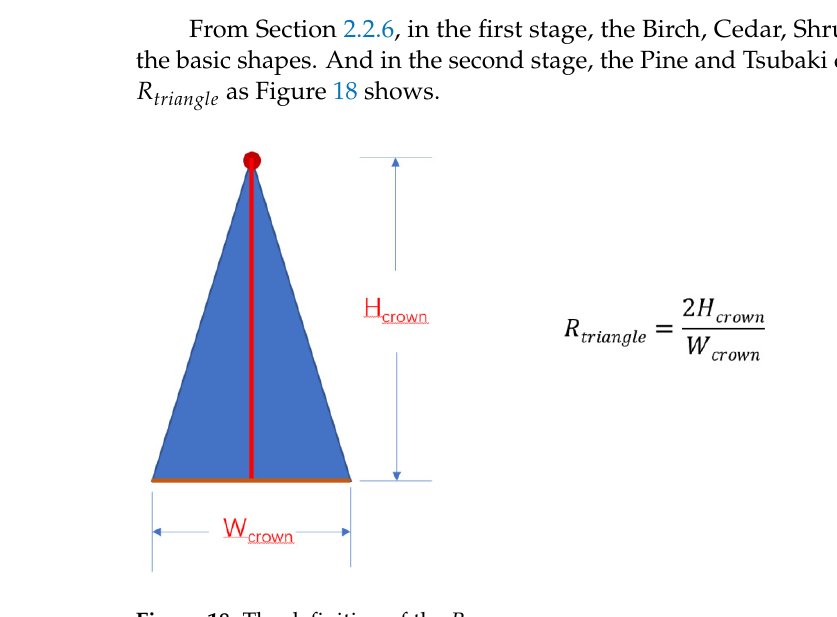
Figure 18. The definition of the R triangle Figure 18. The definition of the 𝑅 (cid:3047)(cid:3045)(cid:3036)(cid:3028)(cid:3041)(cid:3034)(cid:3039)(cid:3032) .